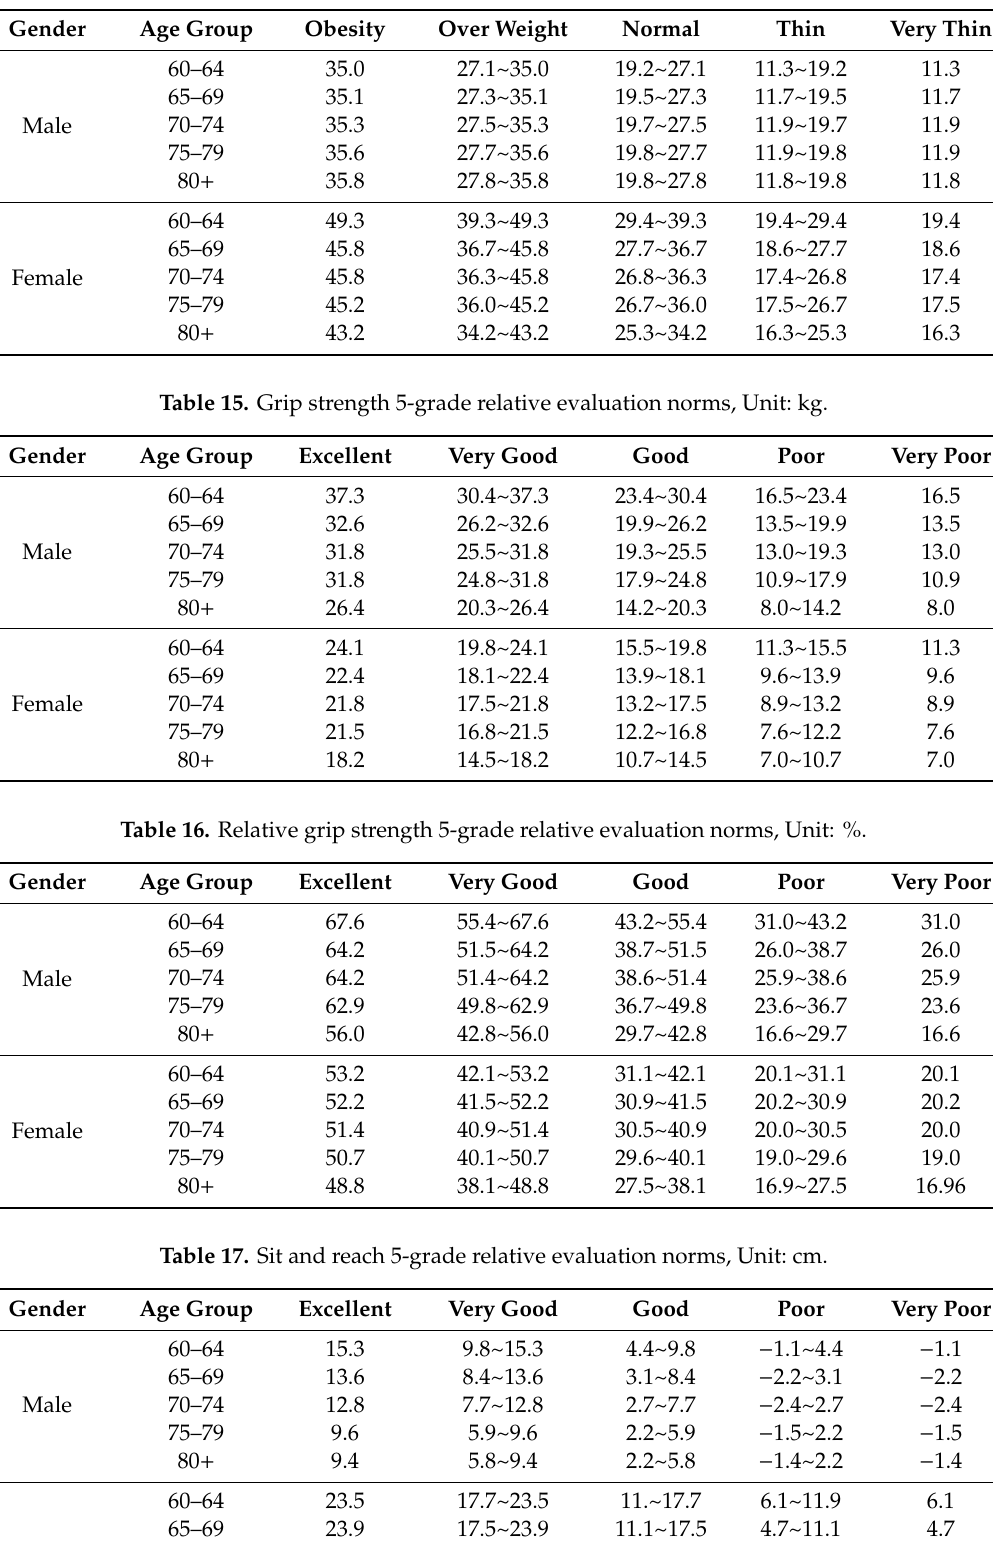
Table 14. Percent body fat 5-grade relative evaluation norms, Unit: %.